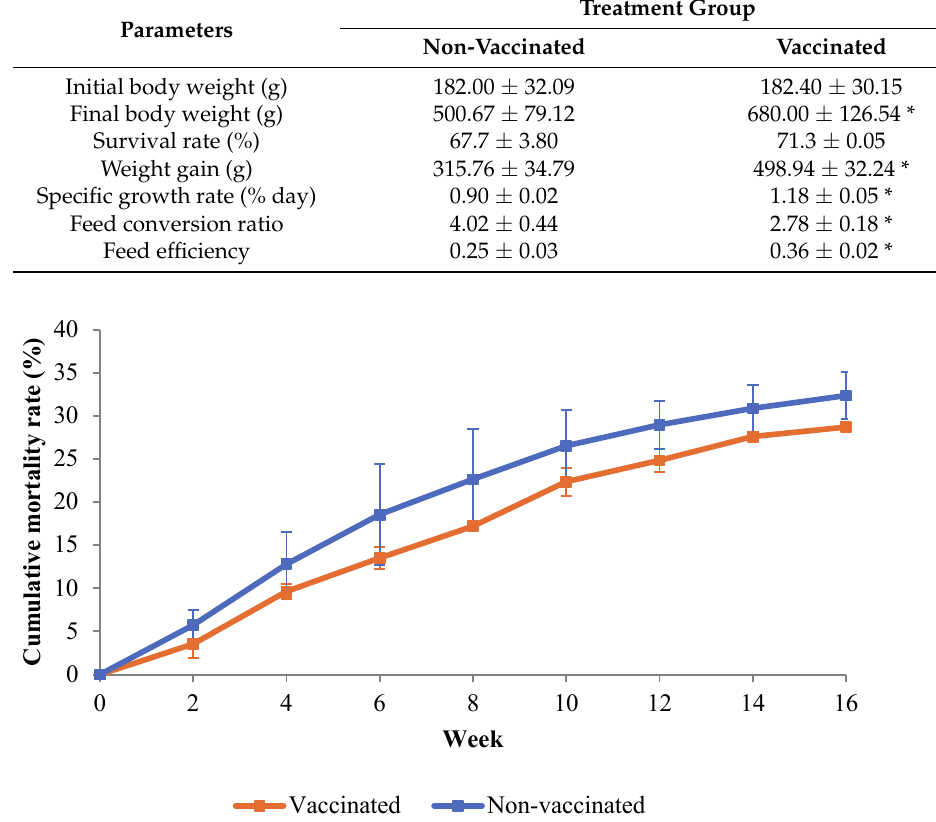
Figure 3. Cumulative mortality rate (%) of the vaccinated and non-vaccinated Asian seabass through- out the vaccination trial. Over the course of the trial, no change was found to be significant ( p >